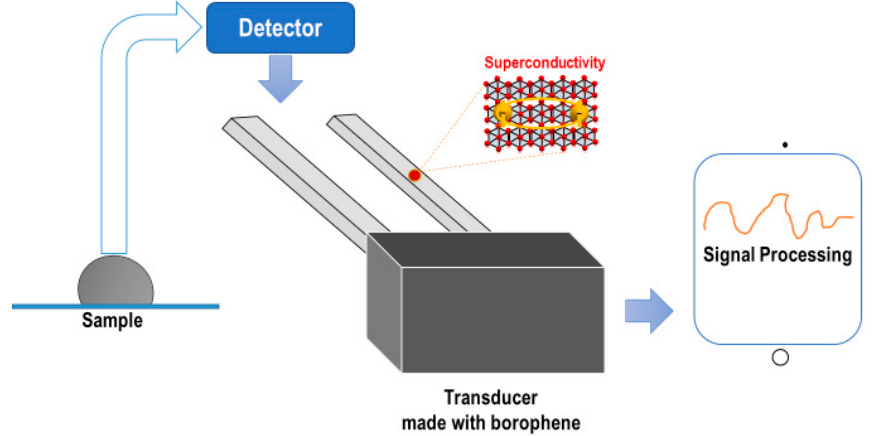
Figure 4. Borophene can reliably play the role of a high-conductivity conductor, thus generating electrical signals in the presence of samples to analyze.